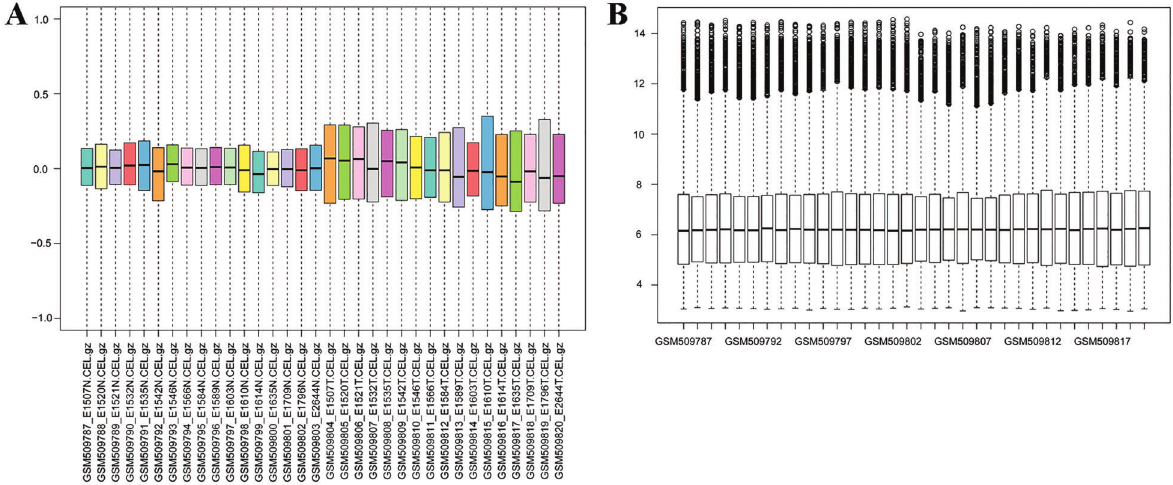
Figure 1. A , Box plot of gene expressions in esophageal squamous cell carcinoma (ESCC) and the matched normal adjacent samples before normalization. B , Box plot of gene expressions in ESCC and matched normal adjacent samples after normalization. The X-axis indicates samples and the Y-axis is expression level of genes. The black line in the center is the median expression value; the consistent distribution represented a good